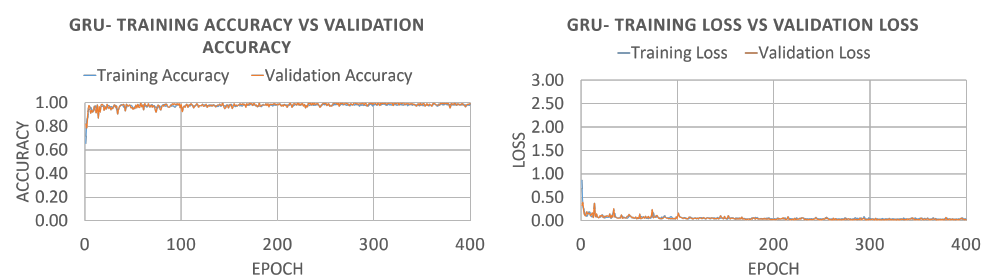
Figure 19. Comparison between the loss and accuracy for the GRU algorithm in both training and validation